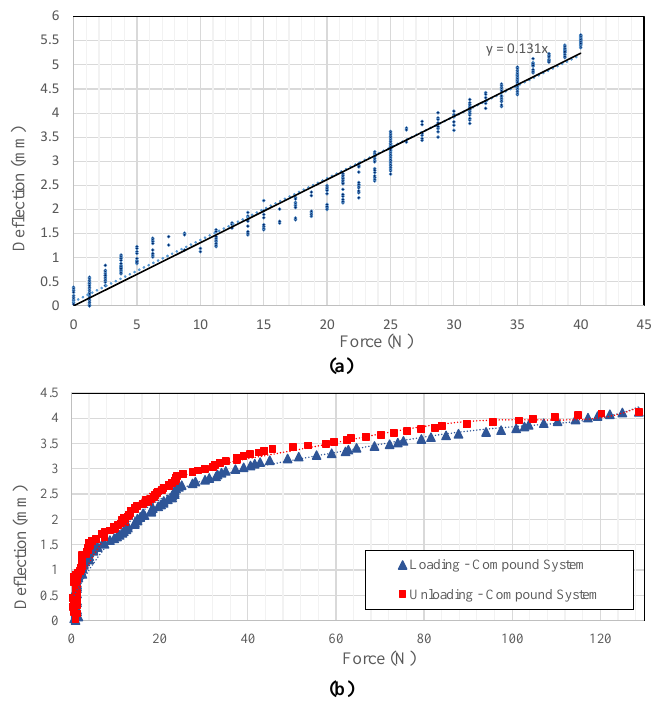
Figure 23. Experiment results using force indenter: deflection vs. applied force plots ( a ) structure only; ( b ) compound